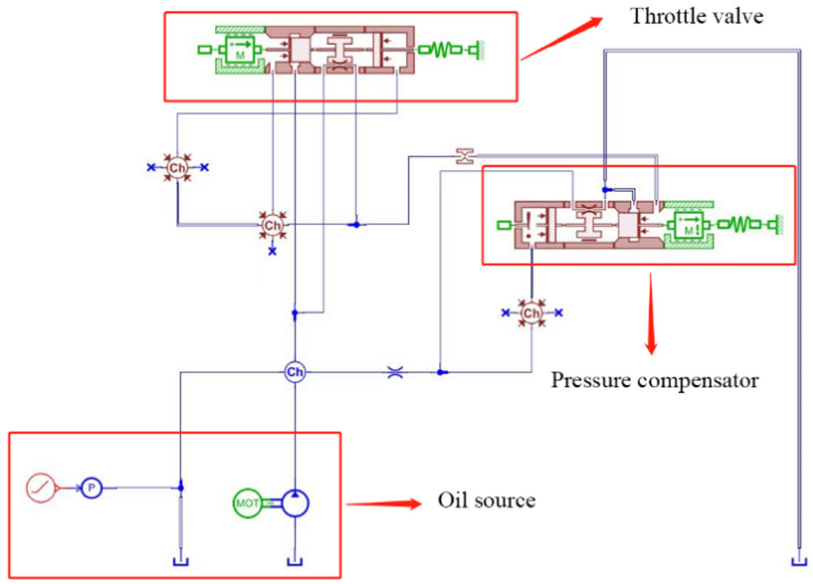
Figure 3. AMEsim simulation model of speed-regulation valve.